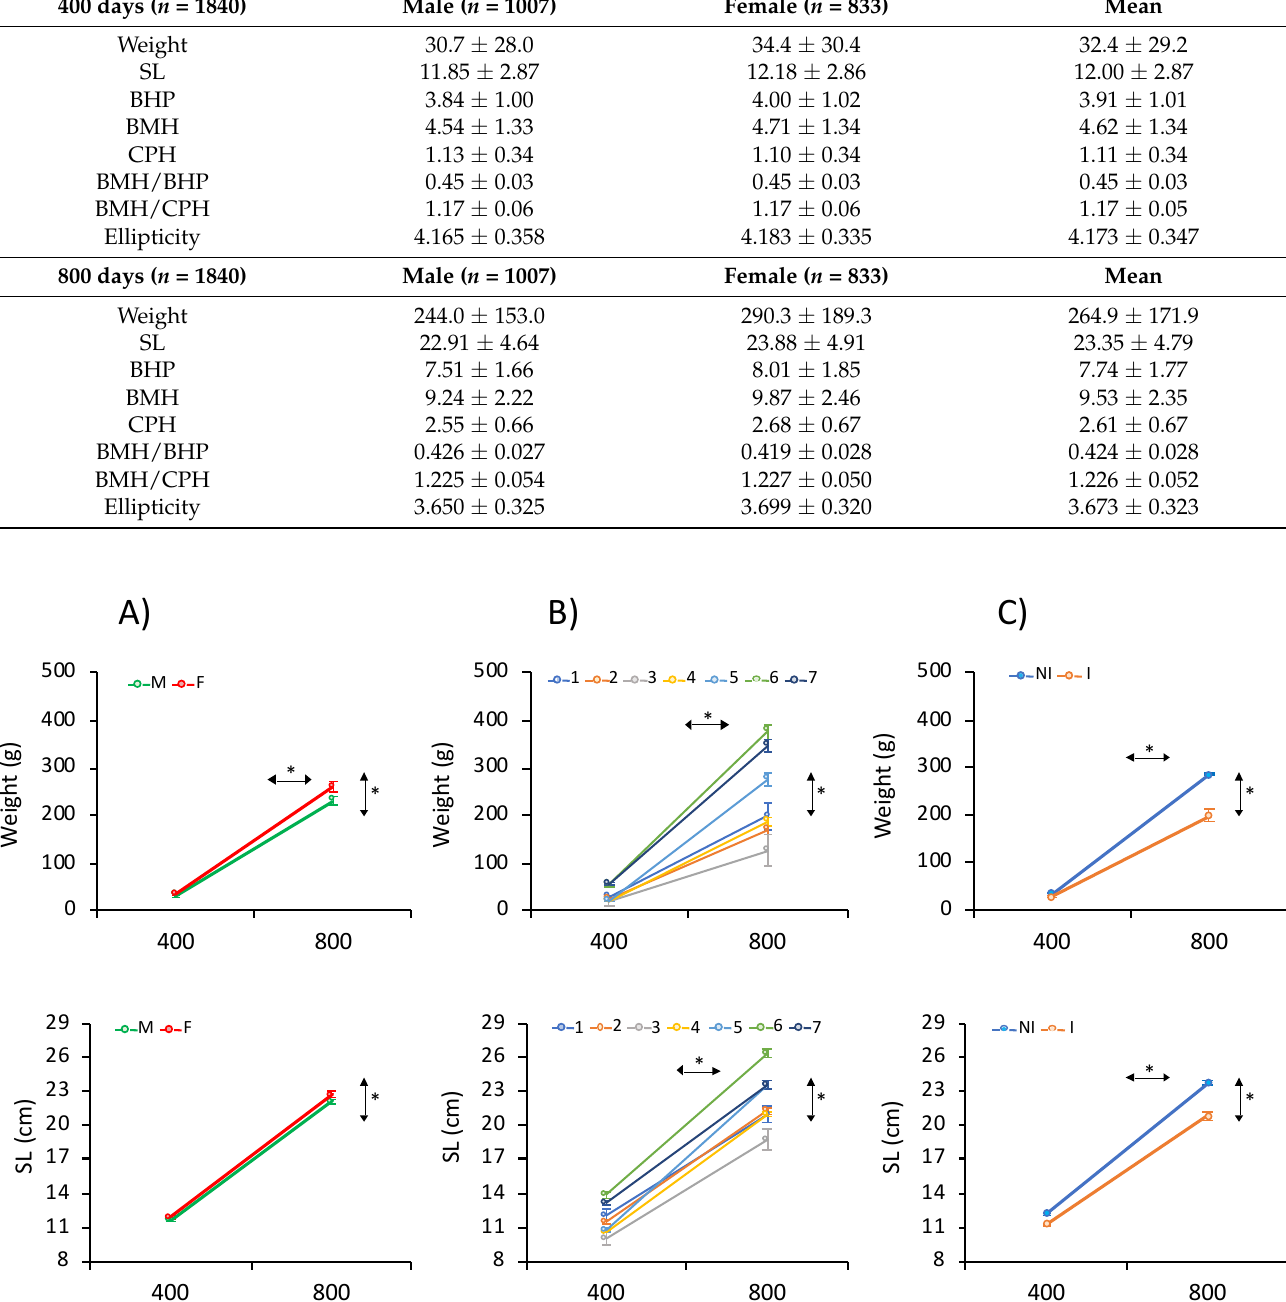
Table 1. Phenotypic data for growth traits (weight and standard length (SL)), heights (body height at the insertion of the pectoral fin (BHP), body maximum height (BMH) and caudal peduncle height (CPH)), height ratios (BMH/BHP and BMH/CPH) and ellipticity at 400 and 800 days (d). Overall mean ± standard error by gender is shown. The number ( n ) of soles evaluated at each age is also indicated.